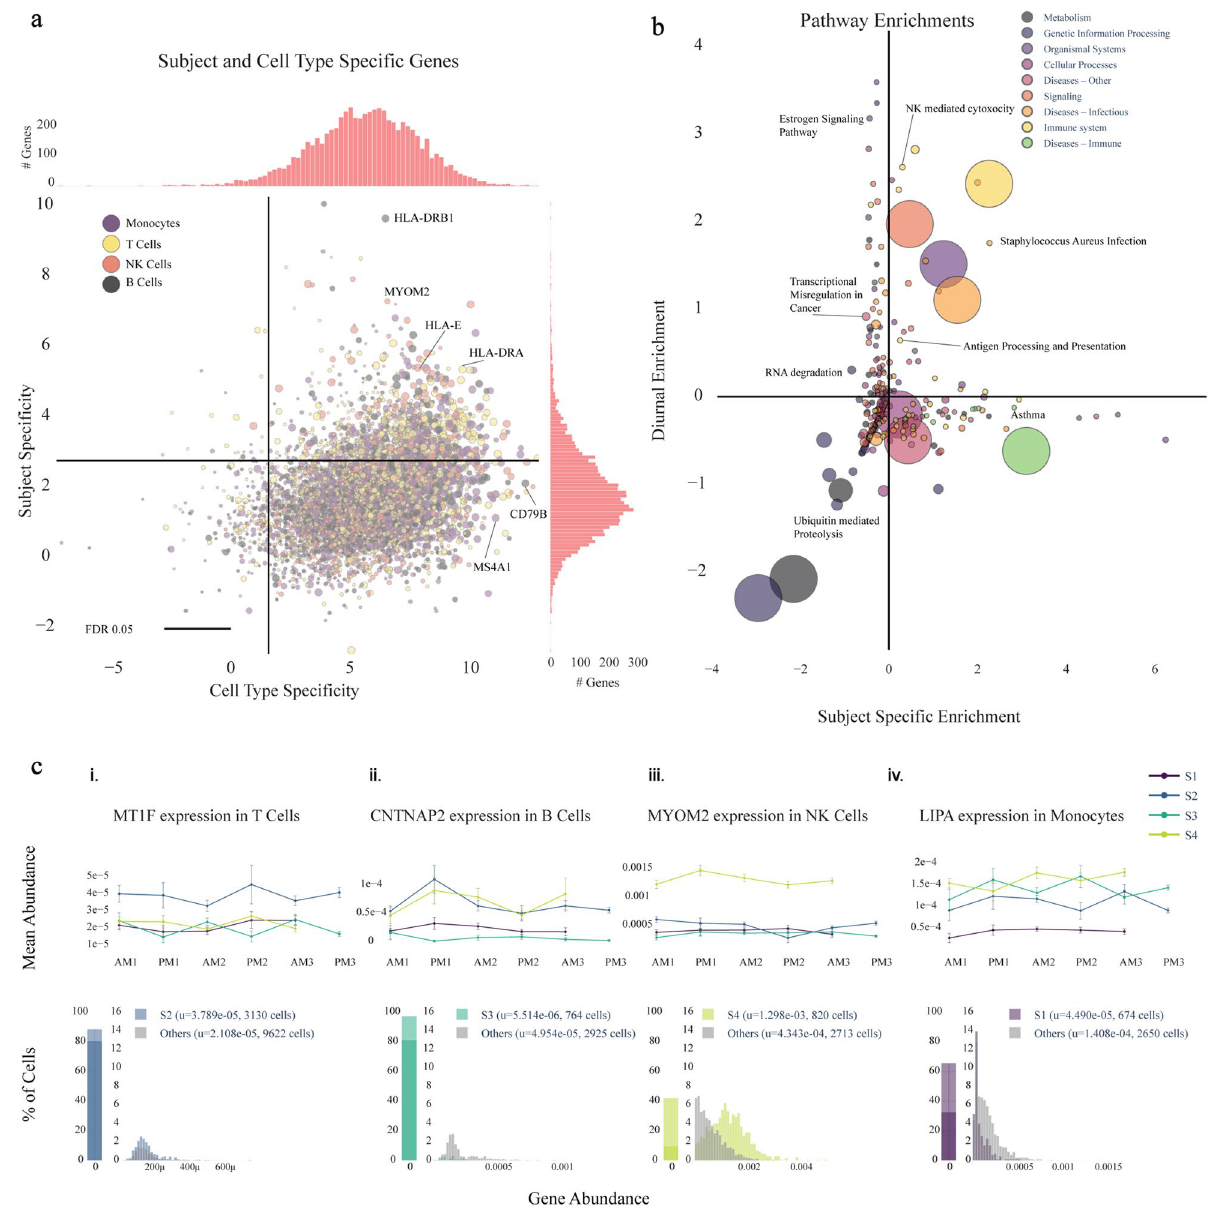
Figure 3. Subject variability in immune and disease-relevant genes and pathways. ( a ) Magnitude (log 2 F statistic) of the variability in expression of genes between different cell types (x) and between subjects (y). 1284/7034 (18.3%) of genes are above the subject specificity significance line (FDR < 0.05, multiple comparison correction) and are classified as subject-specific. Several MHC class II genes (HLA-X) are strongly subject- specific, consistent with previous findings 35 . ( b ) KEGG pathways grouped into categories and their enrichment (Z-score from 2-proportion Z-test) among the top 250 diurnally and subject-varying genes vs all genes. Immune system and disease pathways are significantly enriched (p = 0.029), supportive of the conclusion that immune and disease-related genes are highly subject dependent. The large circles indicate the enrichment of the category overall, and the sizes of the smaller pathway points indicate the number of genes associated with the pathway. ( c ) Subject and cell type specific gene examples for each subject and cell type with the upper row displaying the trace of mean gene expression across time-points and the bottom row showing gene abundance shifts for the subjects of